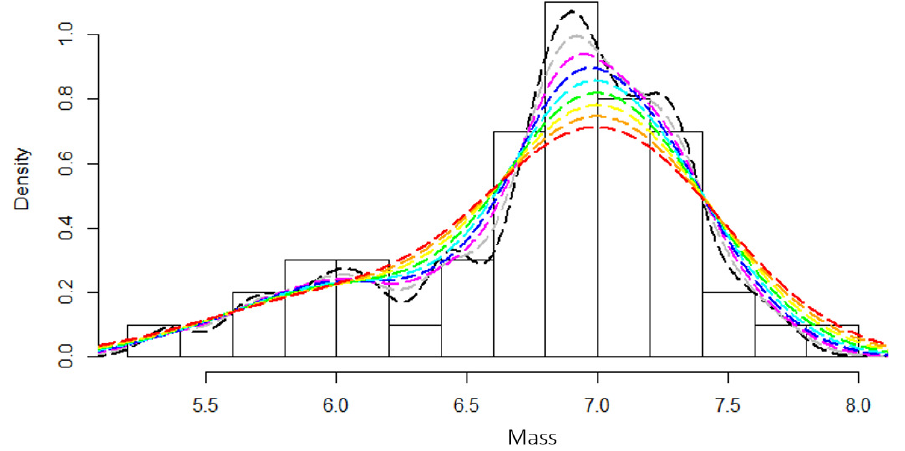
Figure 13. Bandwidth comparison for the faint sample’s BHMF. At higher bandwidths, the faint sam- ple more closely resembles the Davis et al. [53] sample, while at lower bandwidths, some differences emerge. Bandwidth optimization techniques yield a bandwidth of 0.22dex ( ), in log ( M • /M (cid:12) ) , as optimal, i.e., the smaller bandwidths are undersmoothed and the higher bandwidths are oversmoothed . Bandwidth selection does not strongly impact the height of the low-mass tail of the distribution, but more noticeably affects the peak density. Bandwidths of (0.10, 0.13, 0.16, 0.19, 0.22, 0.25, 0.28, 0.31, 0.34)dex are depicted as , , , , , , , , and , respectively. A histogram with bin widths of 0.20dex (similar in width to the optimal bandwidth) is additionally shown in the